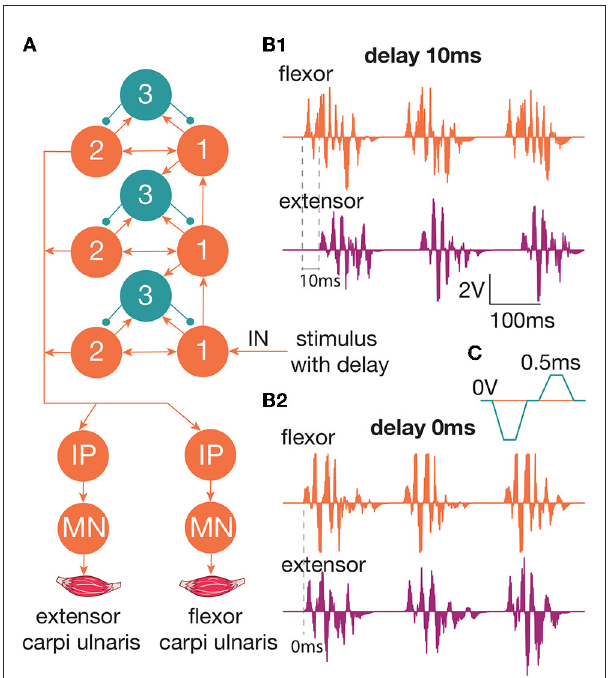
FIGURE2 (A) The diagram of the circuit that produces neuronal activity to trigger the muscle/nerve. This circuit is used for the generation of activity in a spiking neural network. We used a three-layered OM network with a 20-Hz stimulation of the first group of neurons in the first layer. Outputs arrive on the motoneurons of the muscles—extensor carpi ulnaris and flexor carpi ulnaris. (B1) The produced spiking activity with a delay of extensor activity generation 10 ms relative to the flexor. The extensor muscle activity starts after the flexor activity. There are two impulses per 100 ms, which indicate 20-Hz impulses (B2) . The produced spiking activity with a delay of extensor activity generation 0 ms relative to flexor. Both the muscles are active at the same time. (C) The modulation of 2 kHz. Every impulse should be reset to zero voltage every 0.5